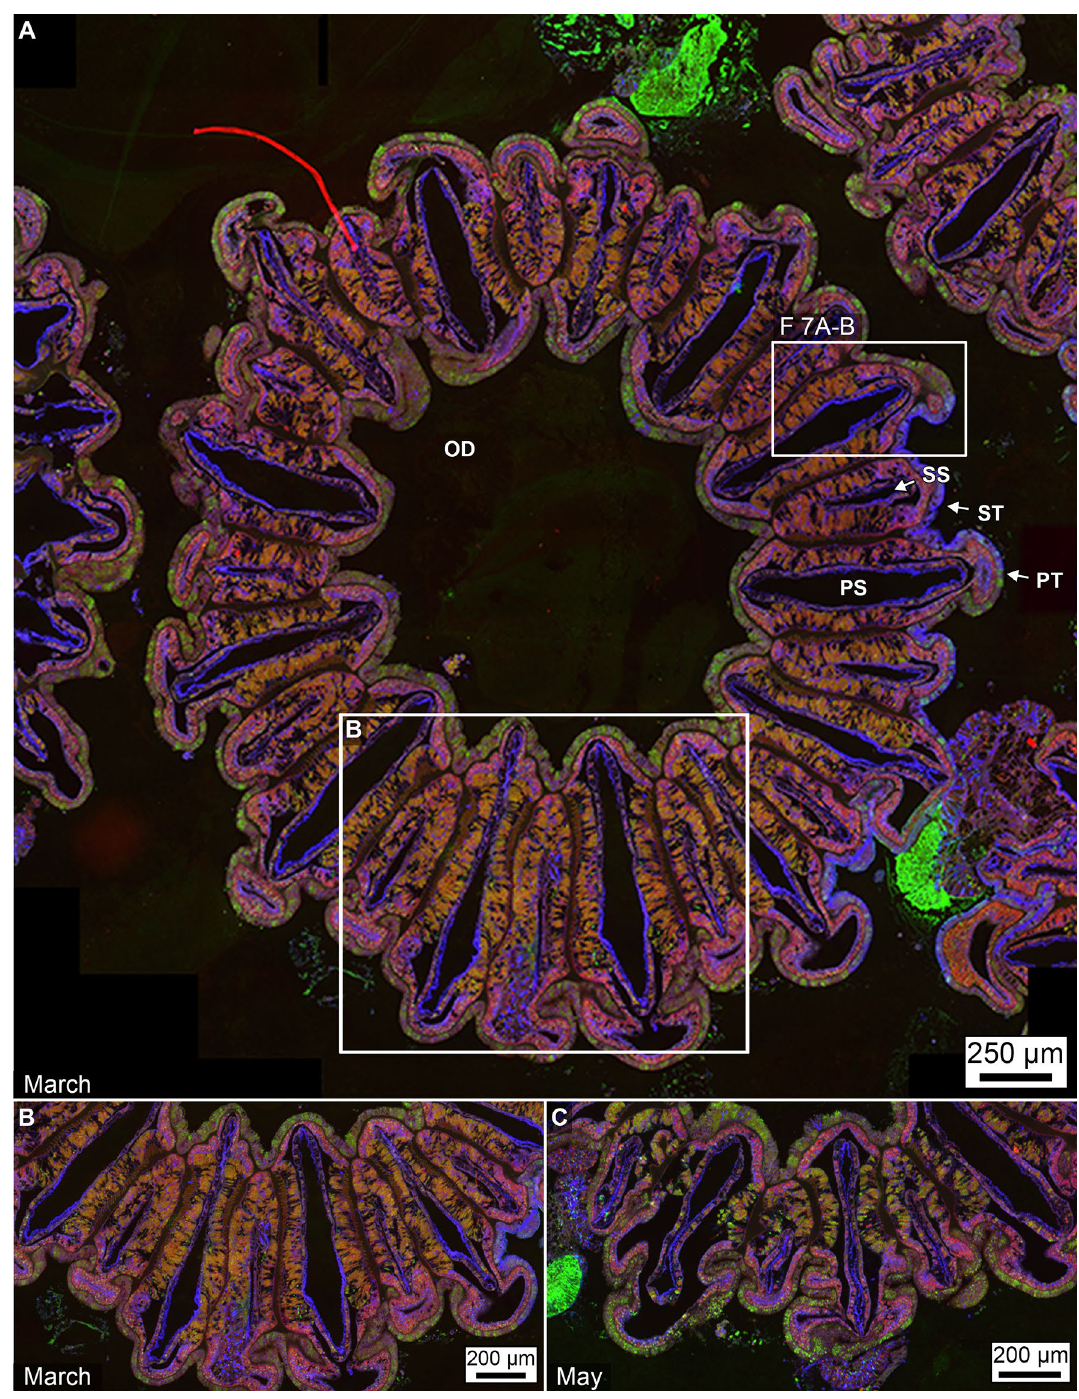
Figure 6. Immunohistochemical fluorescence microscopy of the distributions and abundance of Symbiodiniaceae, chromatophores carbonic anhydrase, calmodulin and mucus within tagged polyp tissues of O. faveolata . ( A ) Horizontal cross-section of decalcified polyp tissues of O. faveolata collected in March 2008 of superimposed emissions from mucus (blue fluorescence), carbonic anhydrase (green fluorescence), and calmodulin (red fluorescence). ( B ) Enlargement of the box shown in A. ( C ) Horizontal cross-section of a decalcified polyp of O. faveolata collected in May 2008 of superimposed mucus (blue fluorescence), carbonic anhydrase (green fluorescence), and calmodulin (red fluorescence). Enlargement from the box shown within a full polyp shown in Supplementary Fig. S7. Labels include: PS—primary septum; SS—secondary septum; PT— primary tentacle; ST—secondary tentacle; and OD—oral